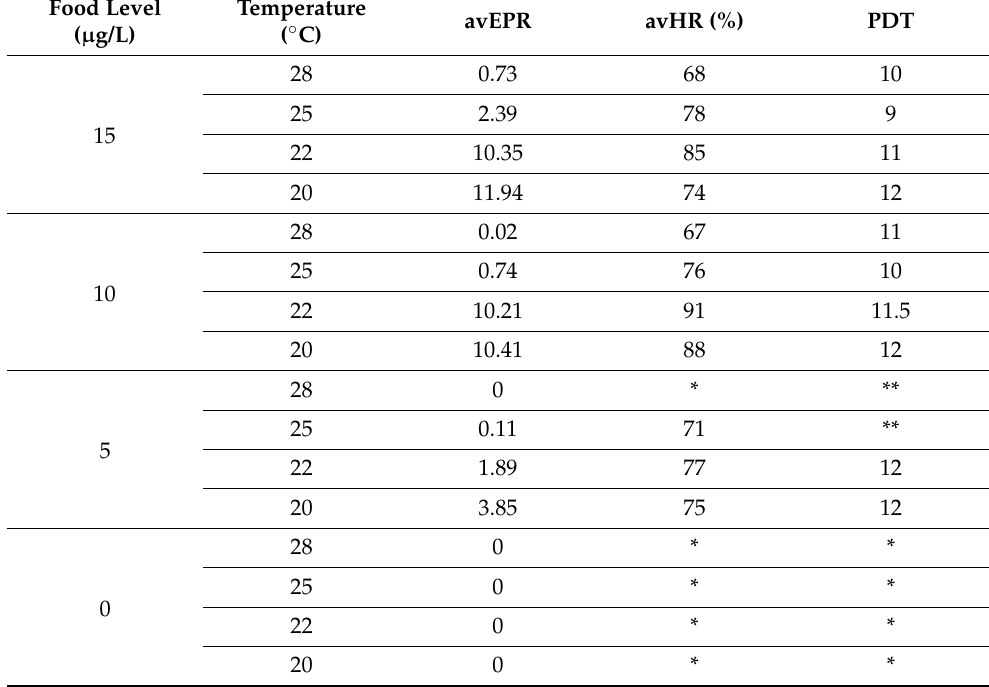
Table 1. The average egg production rate [avEPR, eggs/(female · day)], average hatching rate (avHR), and the post-embryonic development time (PDT, day) from N1 stage to adult of Acartia bifilosa under different seawater temperatures and Chl a